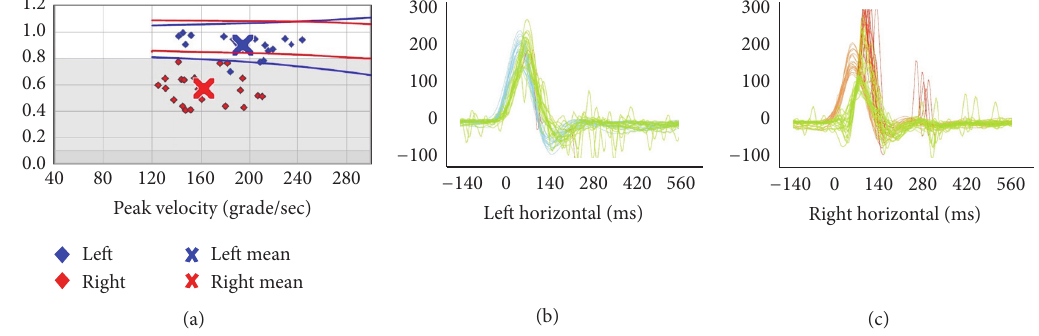
Figure 1: Horizontal passive vHIT before unilateral training: left gain: 0.90 ± 0.08; right gain: 0.57 ± 0.11; asymmetry: